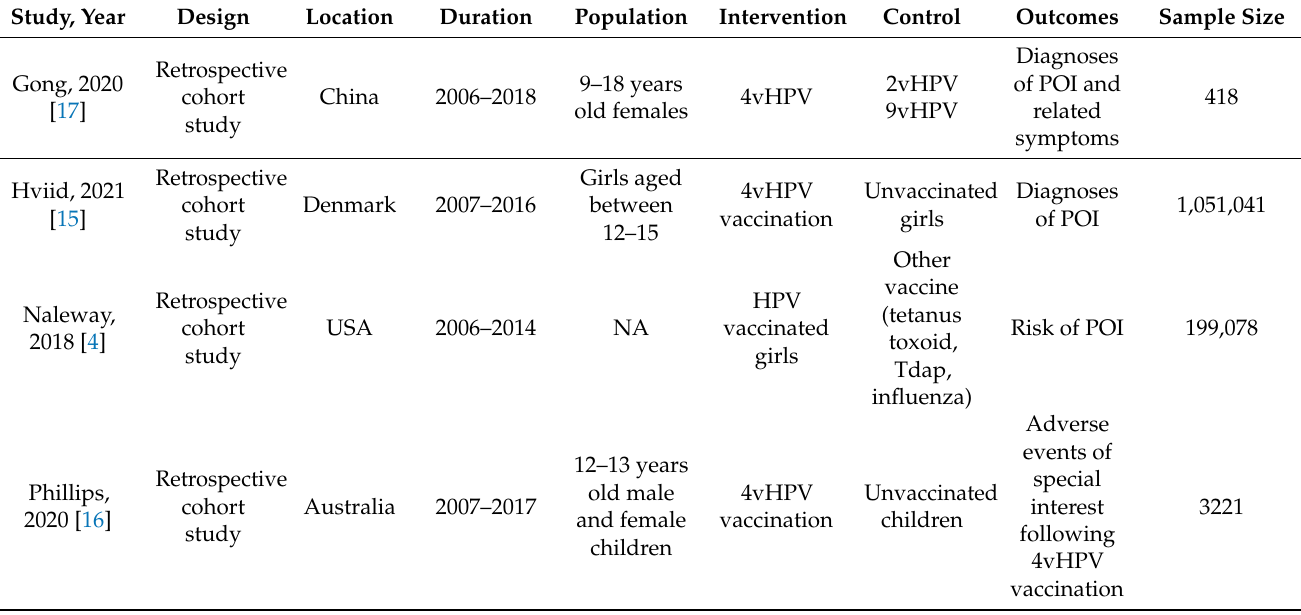
Table 1. Main characteristics of studies included in quantitative synthesis and meta-analysis.